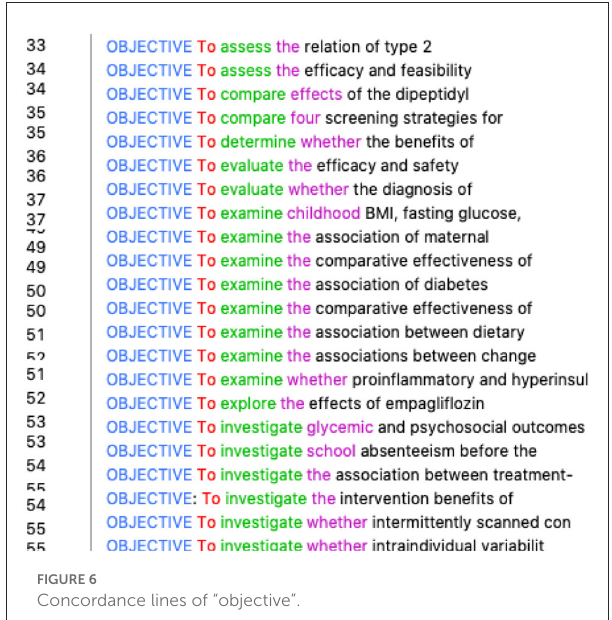
FIGURE6 Concordance lines of